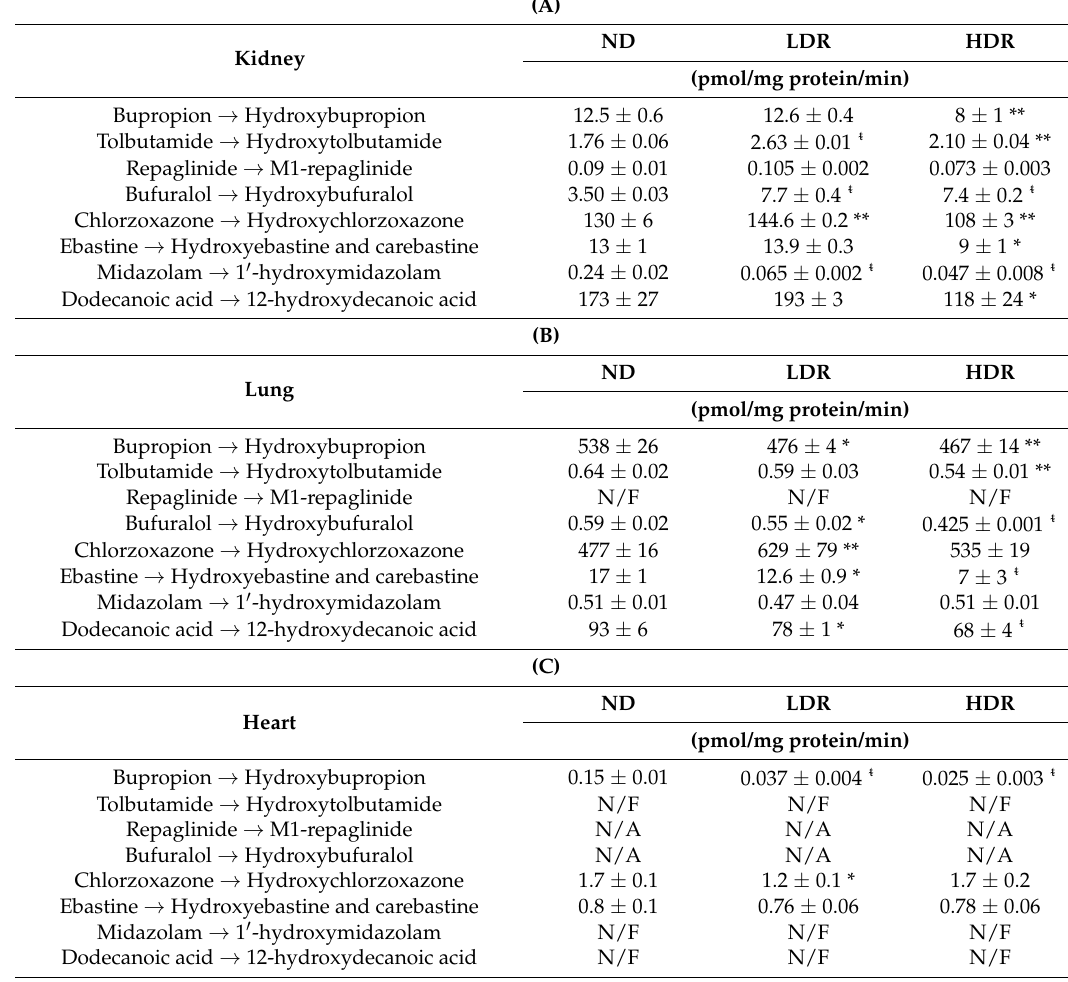
Table 1. Relative mRNA transcripts for each cyp isoform in C57B/6 mice microsomes according to diet group. Tissue